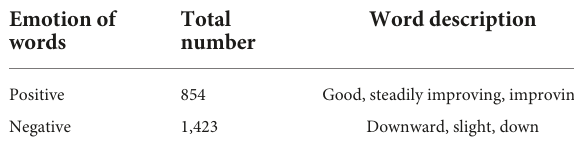
TABLE 2 Summary of subjective expression in financial